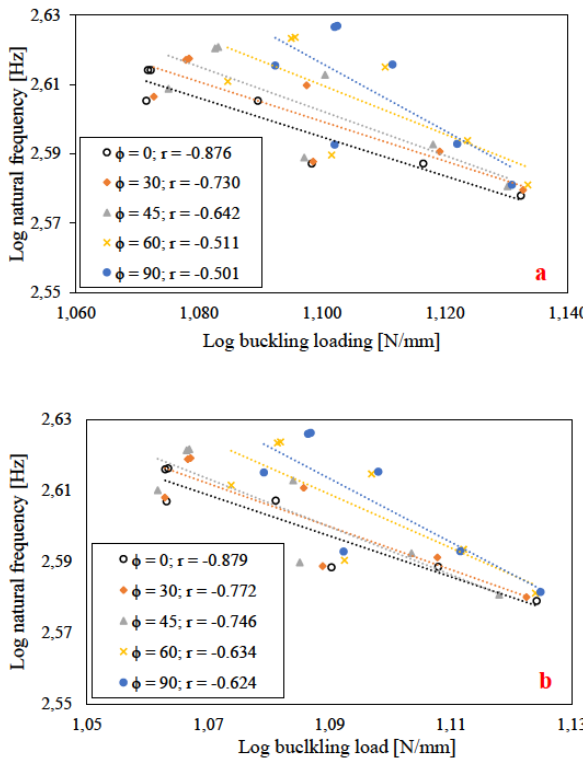
Figure 9: Correlation of natural frequency and buckling load: (a) a/b = 0.2 and (b) a/b = 0.4